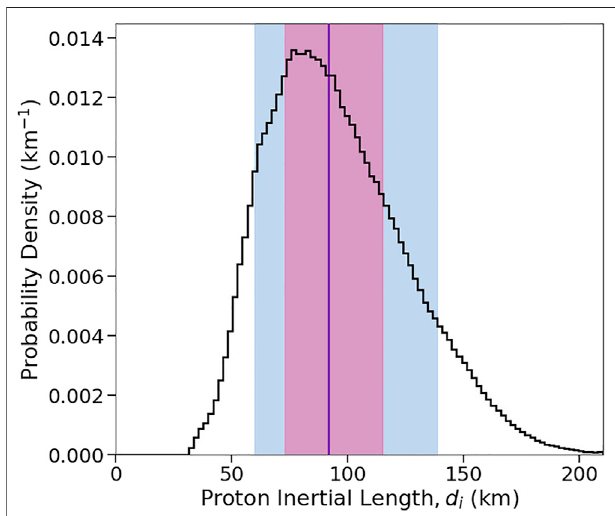
FIGURE 2 | Probability distribution of proton inertial length, d i , from the Wind spacecraft (Acuña et al., 1995; Ogilvie et al., 1995; Wilson et al., 2018). Shaded regions show the (magenta) 25 th to 75 th percentiles and (blue) 10 th to 90 th